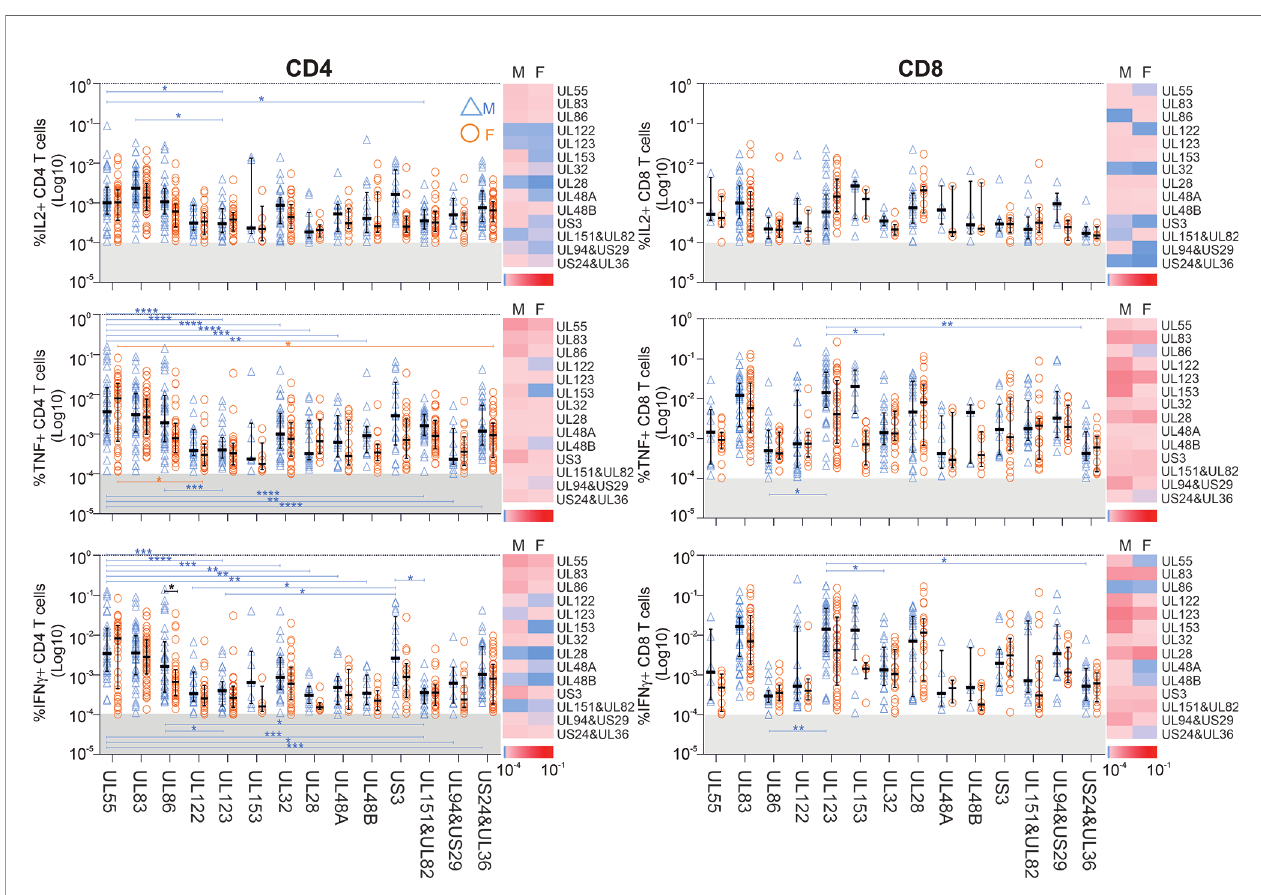
FIGURE 2 | Impact of biological sex on the CD4 and CD8 T-cell reactivity against 14 different CMV peptide pools. PBMCs from males (n=47) and females (n=47) were stimulated with CMV peptide pools; responses below the 1/10,000 threshold were excluded (grey shaded area of each plot). Heatmaps represent response size in males (M) and females (F). As indicated in the scale, darker shades of red represent large responses, while darker shades of blue correspond to low response frequencies. Scatter plots show the frequencies of CD4 and CD8 T-cells responding to the indicated CMV proteins in males (blue empty triangles, M) and females (orange empty circles, F). Error bars show median and interquartile range. Statistical differences in response sizes with respect to different CMV protein were assessed in 2-way ANOVA (addressing both the effect of ‘ sex ’ and ‘ CMV protein ’ on the size of the cytokine response, Table S3 ) followed by multiple end-point correction. Differences between proteins within males and females are shown by blue and orange lines, respectively, and differences between males and females by black lines. Signi fi cance levels are: * p ≤ 0.05; ** p ≤ 0.005; *** p ≤ 0.0005; **** p ≤